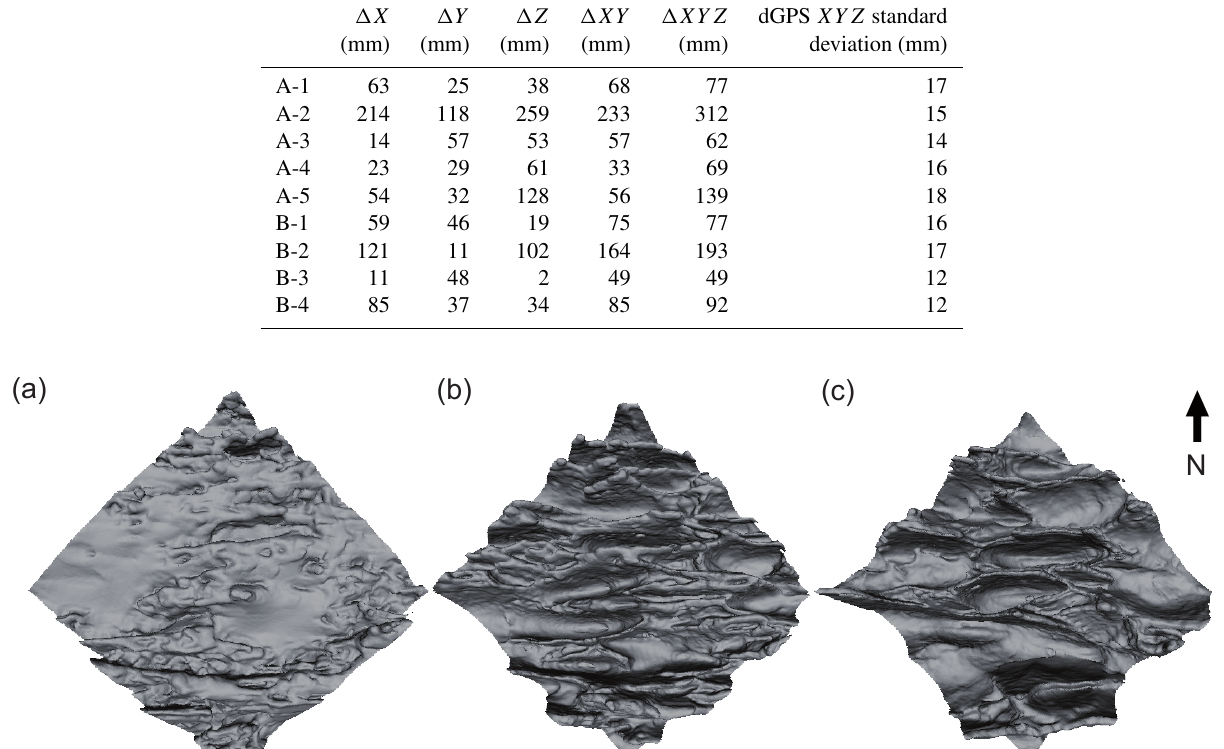
Table 1. Maximum absolute georeferencing error at each marker stake for site A and B, relative to the standard deviation of the differential GPS measurement.